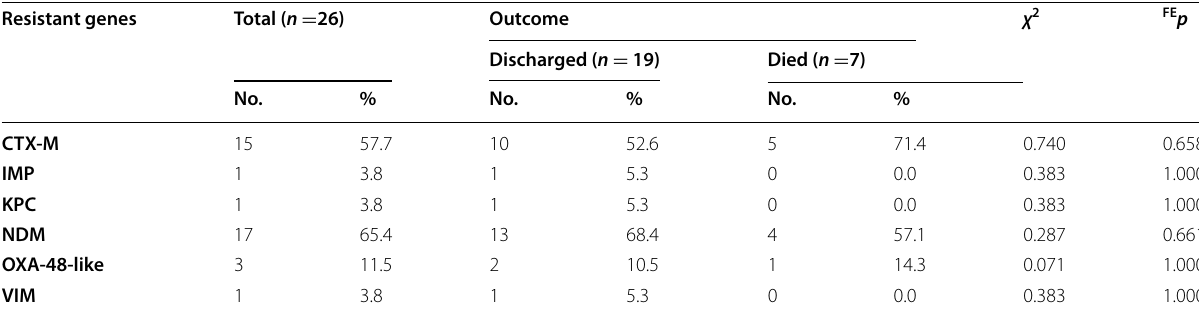
χ 2 chi‑square test, FE Fisher’s exact, CTX-M cefotaximase, IMP imipenemases, OXA oxacillinase, KPC Klebsiella pneumonaie carbapenemases , NDM New‑delhi M, VIM Veronem integron M